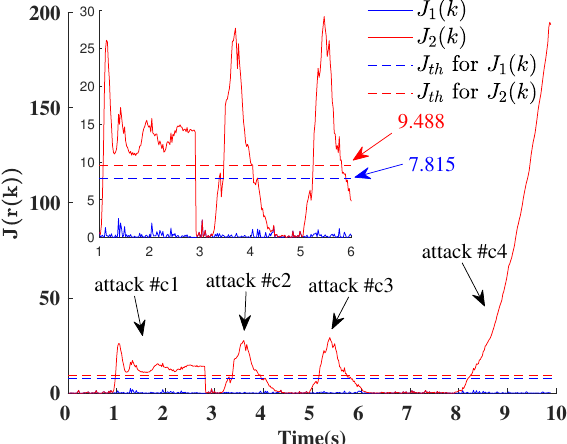
Figure 8. The detection results of covert attacks based on r 0 ( k ) and r β ( k ) . Any one of the four covert attacks (see Table 1) can cause the OMR to deviate from its expected trajectory, but due to the detection of the method based on r β ( k ) , the control system can be aware of the attacks on the OMR in time and thus make preventive as well as rescue measures. Among them, there is a small period before J 2 ( k ) for both turn attacks (i.e., attack #c2 and attack #c3) reach the alarm threshold. This is because the ˙ x , ˙ x c are basically the same when the OMR is turning left and right, and only the ˙ y , ˙ y c and ˙ θ , ˙ θ c are different, see Figure 5. So J 2 ( k ) take a small time to reach the alarm threshold. However, this is enough to prove the effectiveness of the method based on r β ( k )